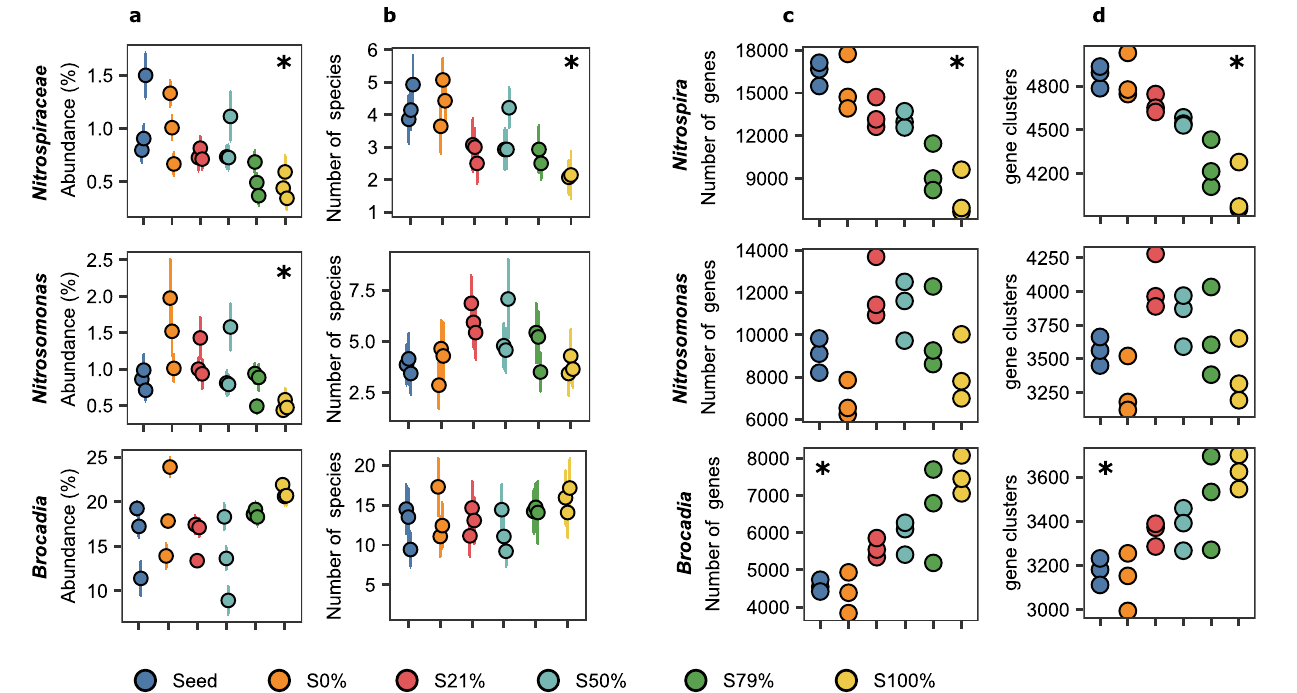
Fig. 3 Abundance and richness of Nitrospira (top), Nitrosomonas (middle), and Brocadia (bottom) in the metagenome dataset. a Relative abundances. b The number of species. c The number of genes. d Number of pangenome gene clusters. a , b singleM data; circles show average values of 14 marker genes, error bars indicate 95% con fi dence intervals. c , d Kaiju data. Note that Kaiju uses NCBI taxonomy, while singleM uses GTDB taxonomy; in the latter the genus Nitrospira is classi fi ed as the family Nitrospiraceae . Pearson correlation was estimated for sidestream exposure from 0 to 100%, for the singleM average ( a , b ) and the Kaiju values ( c , d ); an asterisk ( * ) is used to show signi fi cant correlations ( p < 0.05).